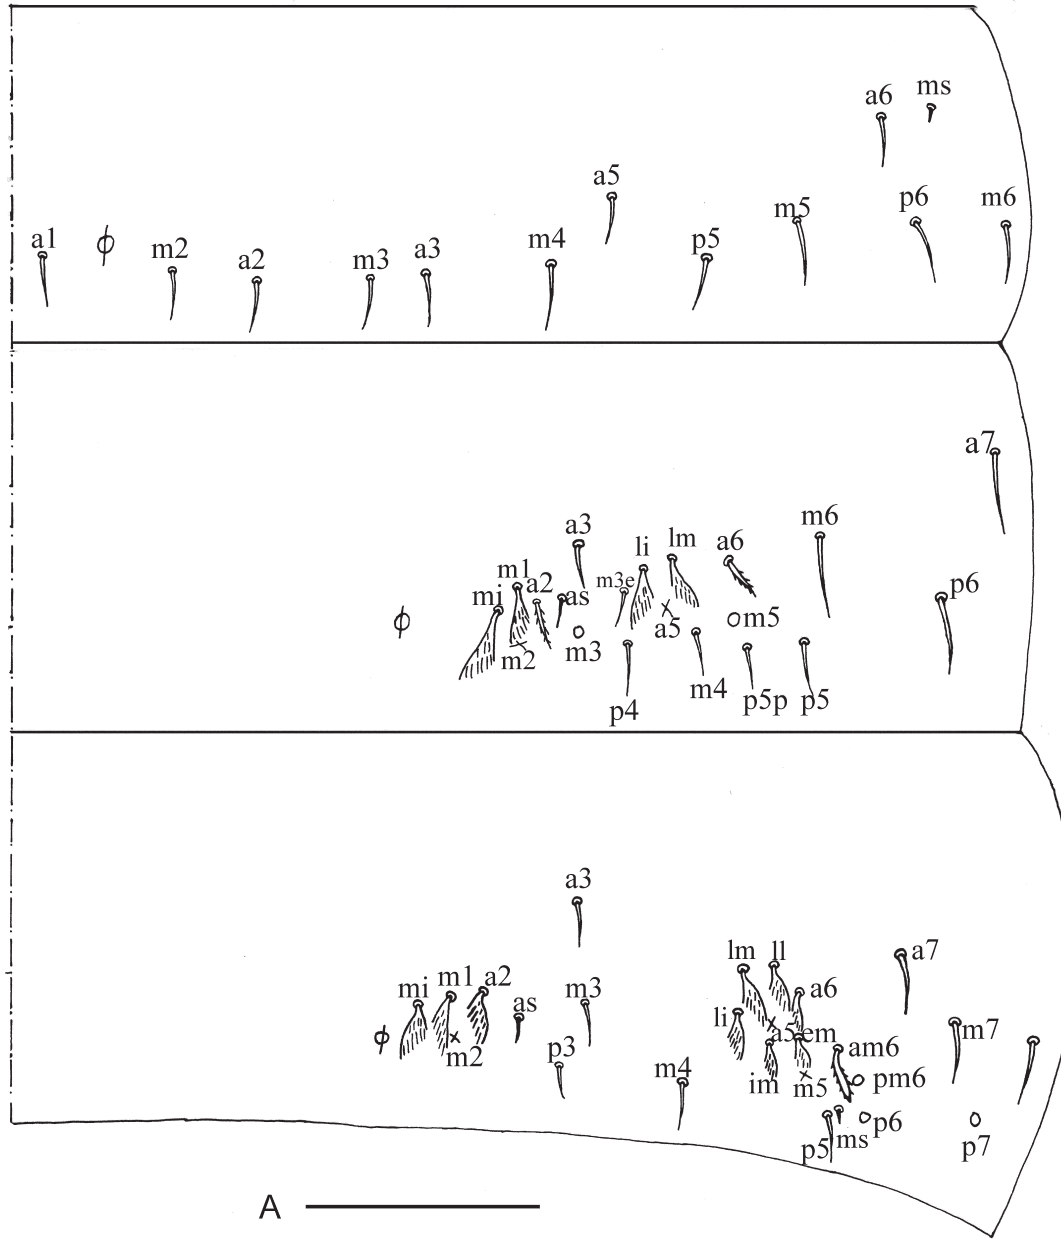
Fig. 14. Lepidocyrtus ( S. ) wanningensis sp. nov., chaetotaxy of Abd. I−III (right side). Scale bar: 70